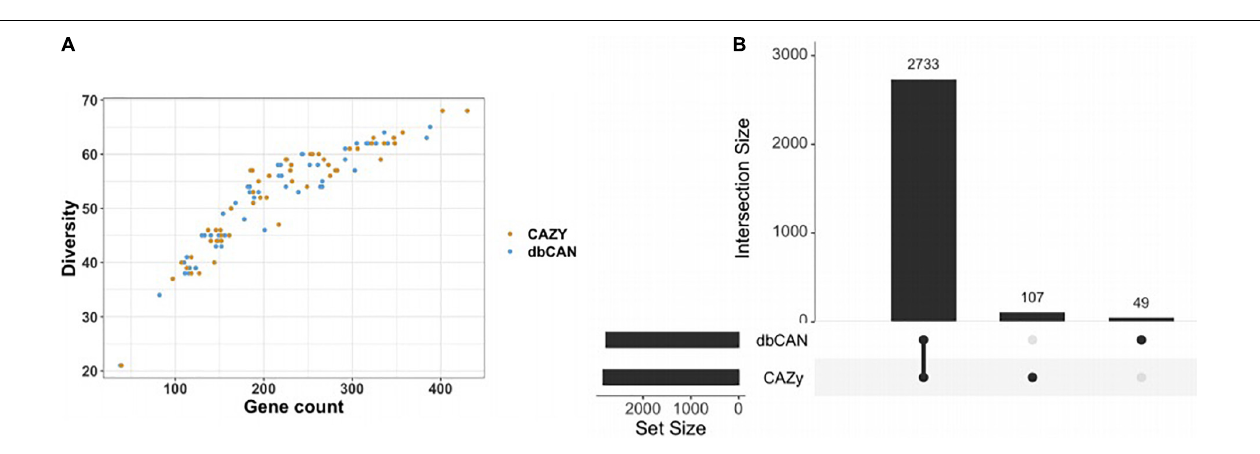
FIGURE 2 | Number of common and different GH counts obtained by CAZy and dbCAN annotation methods. Annotations were performed on 54 different Bacteroidetes genomes on which the annotation was performed while screening for 87 different GH families. (A) A similar plot to El Kaoutari et al. (2013) highlighting a trend between the number of different GH family diversity and the GH total gene counts per genome. (B) A Venn diagram displaying, among all the GH predicted by dbCAN or CAZy, the number of common ones and different ones. Here, 2,733 genes were identically annotated by the two tools, while the manually curated CAZy brought 107 different annotations and dbCAN 49 others. Note that CAZy returned more GH genes than